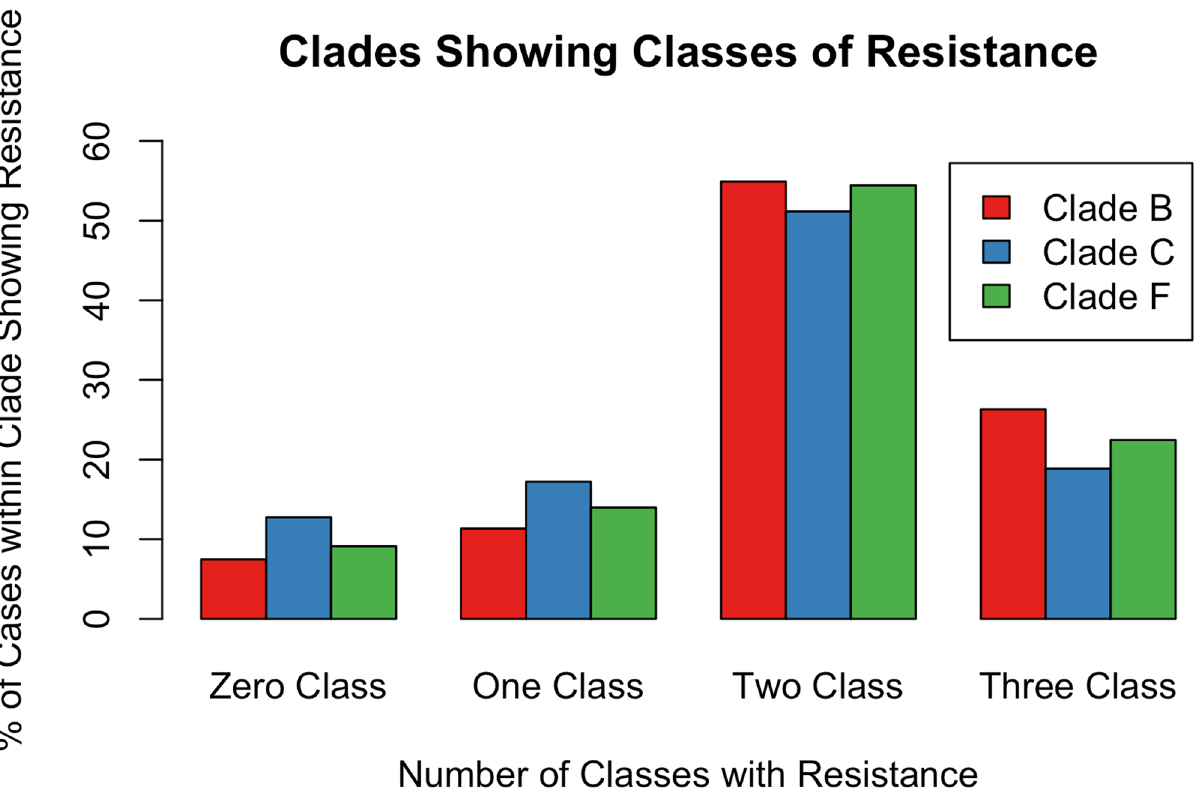
Fig 9. Antiretroviral class resistance by clade. Percentage of resistance to different antiretroviral classes by Clade (B, C and F) among patients treated between 2003 and 2009.